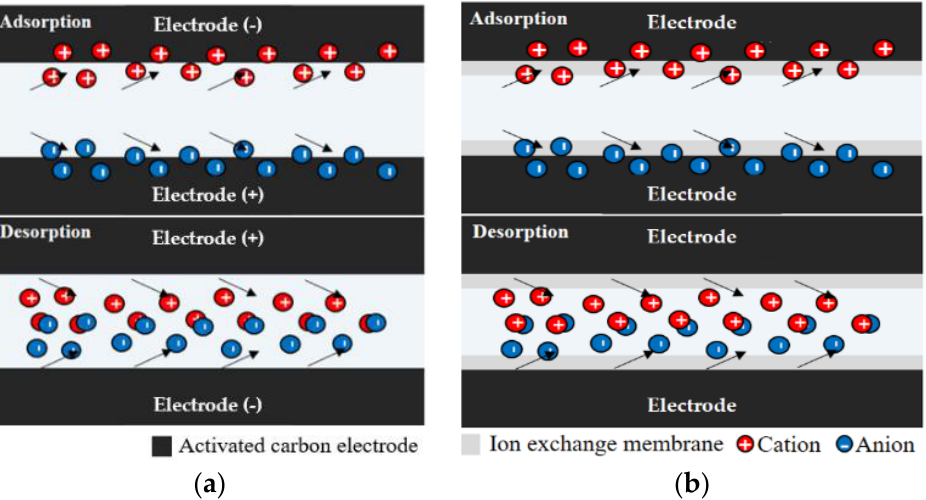
Figure 1. Principle of ( a ) capacitive deionization (CDI); ( b ) membrane capacitive deionization (MCDI).